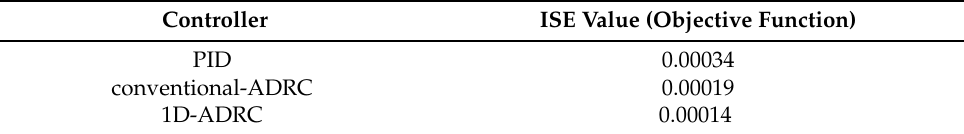
Table 3. ISE value for different controllers.